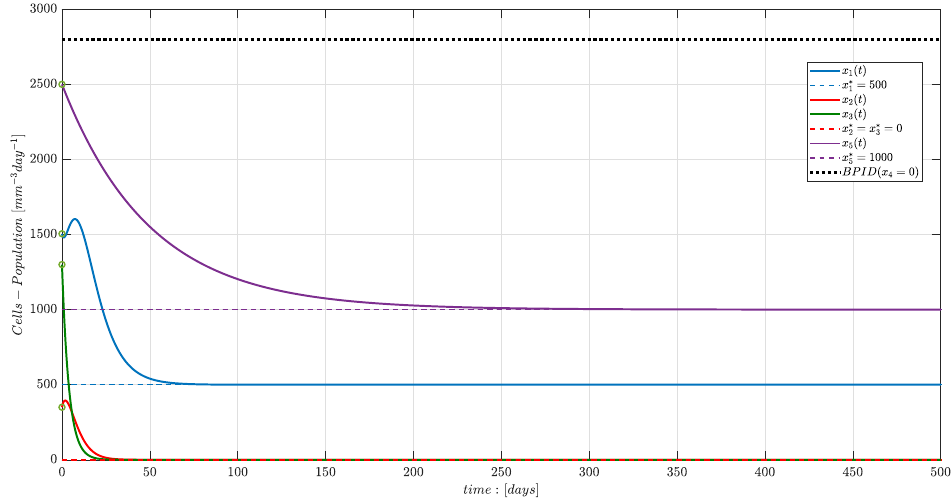
Figure 1. Upper bound for all cell population sets by the bounded positive invariant domain (BPID) set K 1 , considering the invariant plane x 4 ( t ) =